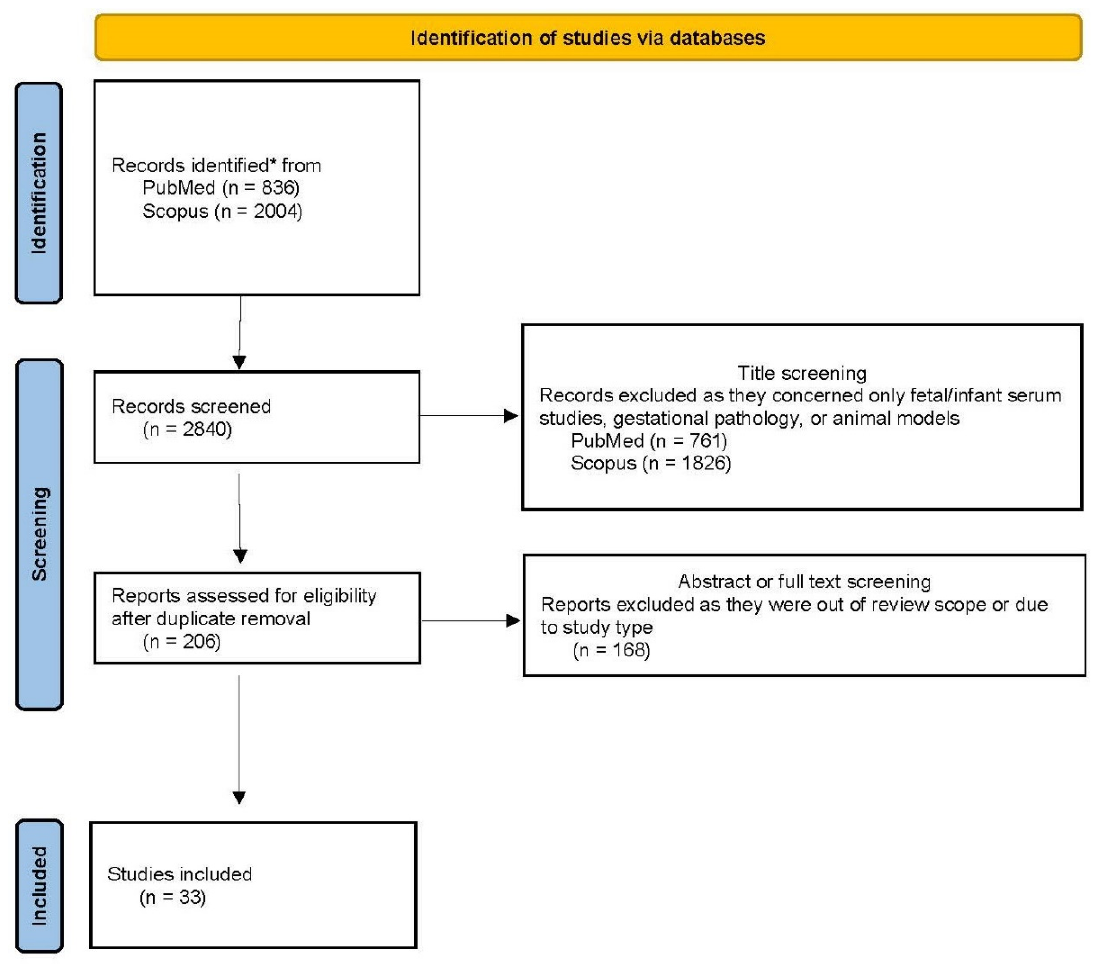
Figure 1. Flowchart of the study [27], * ((“maternal appetite molecules” OR “maternal appetite hormones” OR leptin OR ghrelin OR NPY OR PPY OR PP OR GLP-1 OR IGF-1 OR cholecystokinin OR oxyntomodulin OR GIP) AND (“fetal growth” OR “fetal metaboli *” OR “birth anthropometr *” OR “birth weight” OR “offspring metaboli *”)).